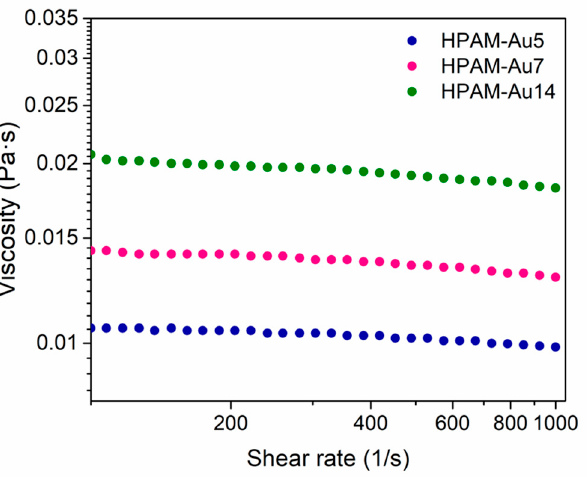
Figure 7. Viscosity variation as a function of the shear rate at 25 °C of nanocomposites in solution prepared at different pHs: HPAM-Au5 (acidic), HPAM-Au7 (neutral), HPAM-Au14